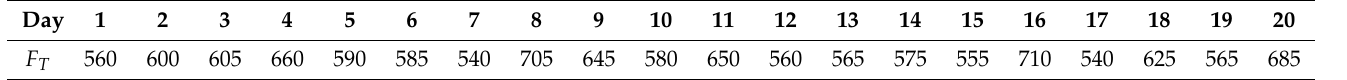
Table 7. Daily flow time ( F T ) [min] data collected for 20 days for the product Model A. Day